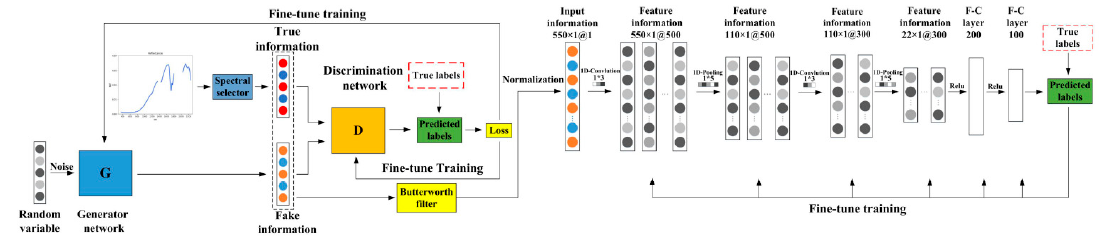
Figure 4. Structure of the oil thickness inversion generative adversarial and convolutional neural network (OG-CNN) model.